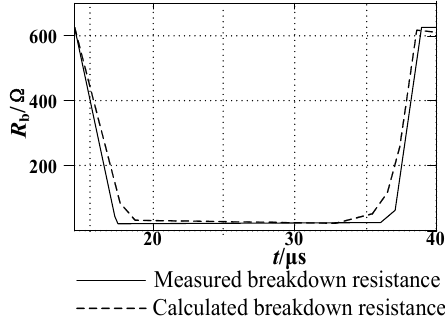
Figure 8. Equivalent resistance of the measured and calculated curve.